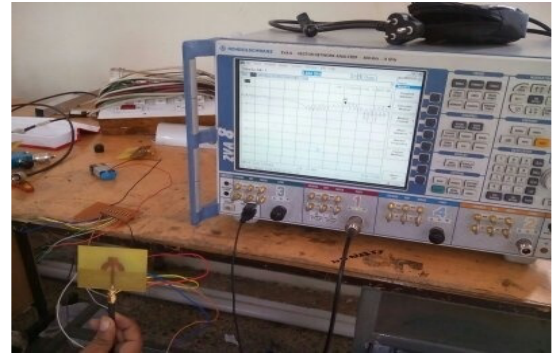
FIGURE 10. Fabricated antenna connected to Vector Network